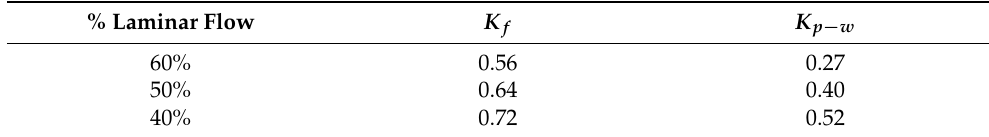
Table 3. Drag penalty